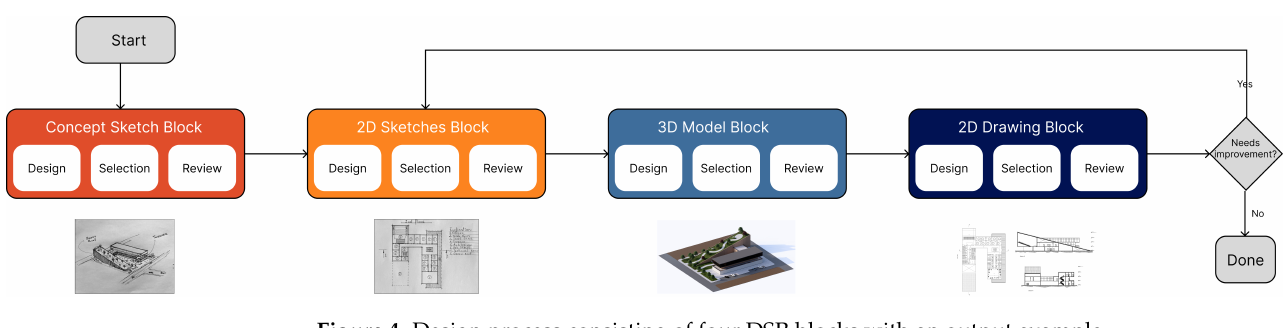
Figure 4. Design process consisting of four DSR blocks with an output